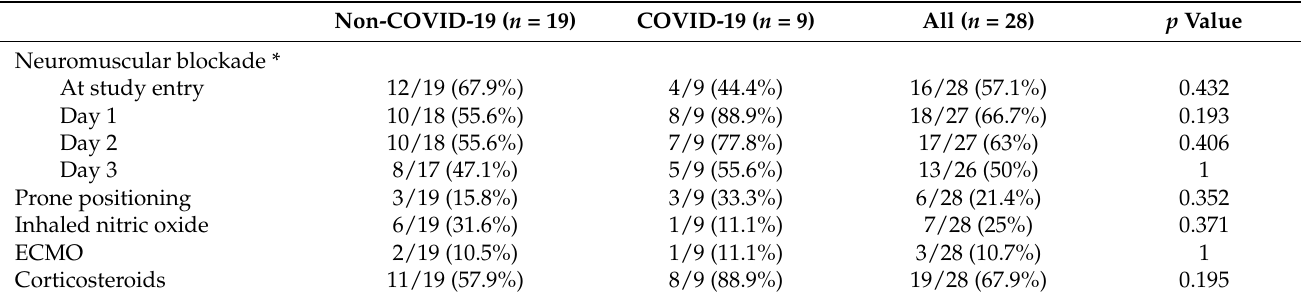
Table 3. Ancillary treatments for the total cohort of 28 patients, 9 COVID and 19 non-COVID-19, during the first three days in the Pediatric Intensive Care Unit.